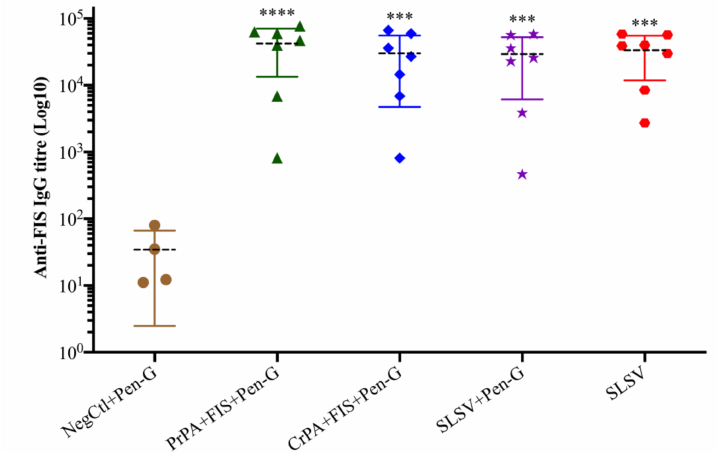
Figure 3. Anti-formalin inactivated Bacillus anthracis 34F2 spores (FIS) IgG-titres at week 5 in cattle. The cattle were vaccinated twice at weeks 0 and 3 with PrPA + FIS + Emulsigen-D ® / Alhydrogel ® plus Pen G ( n = 7), CrPA + FIS + Emulsigen-D ® / Alhydrogel ® plus Pen G ( n = 7), Sterne live spore vaccine (SLSV) plus Pen-G ( n = 7), SLSV ( n = 7) and NegCtl (Emulsigen-D ® / Alhydrogel ® plus Pen-G) ( n = 4). The IgG titres of each group were compared to the respective titres at week 0 before vaccination (**** p < 0.0001, *** p < 0.001, ** p < 0.01, * p ≤ 0.05). Purified recombinant protective antigen: PrPA; Crude recombinant protective antigen: CrPA; Formalin inactivated Bacillus anthracis spores: FIS; Penicillin-G: Pen-G; Sterne live spore vaccine: SLSV; Negative control: